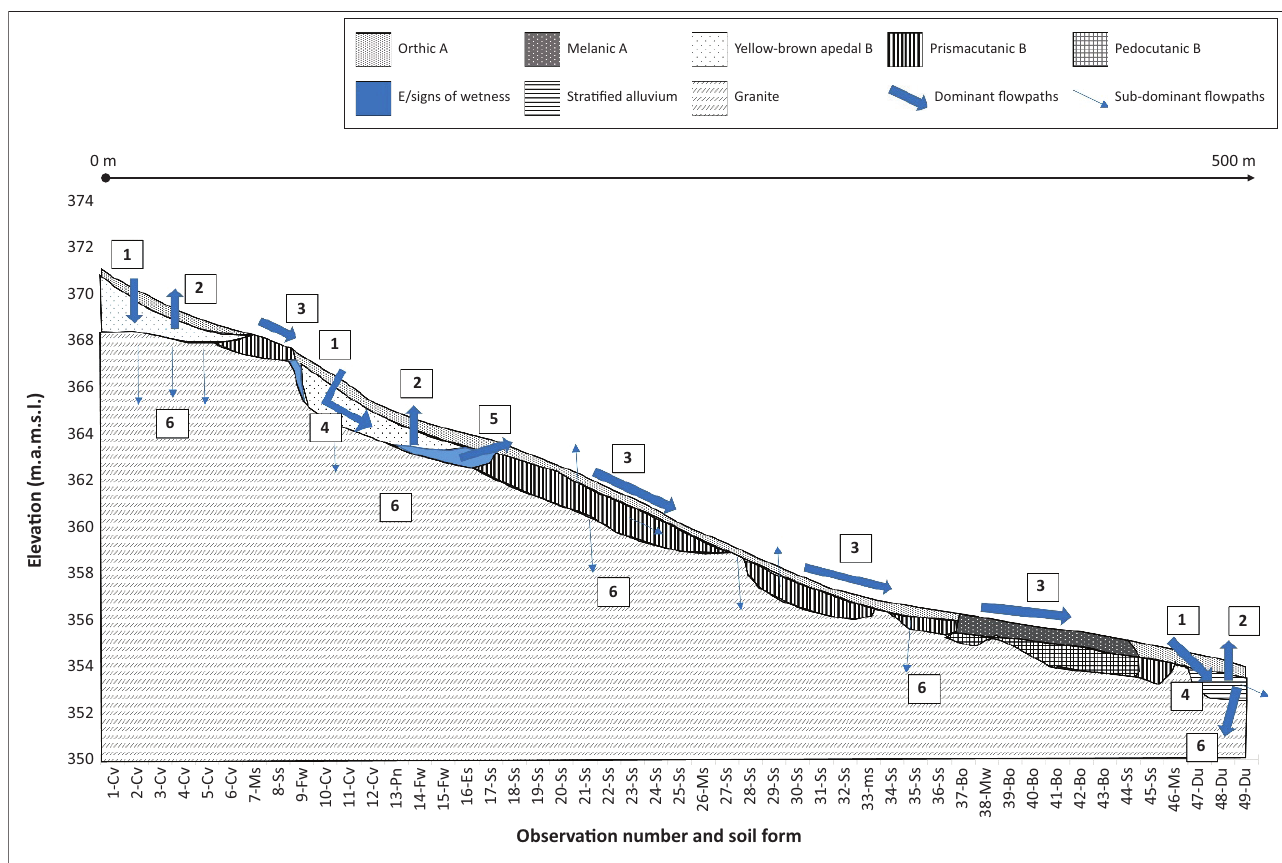
FIGURE 6: Conceptual hydrological response model of a third-order stream in the Kruger National Park. Vertical axis exaggerated for display purposes.